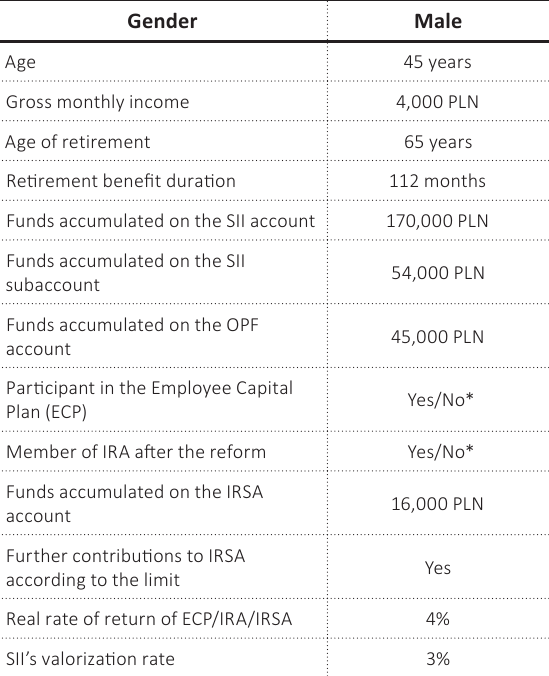
Table 4. Input data for